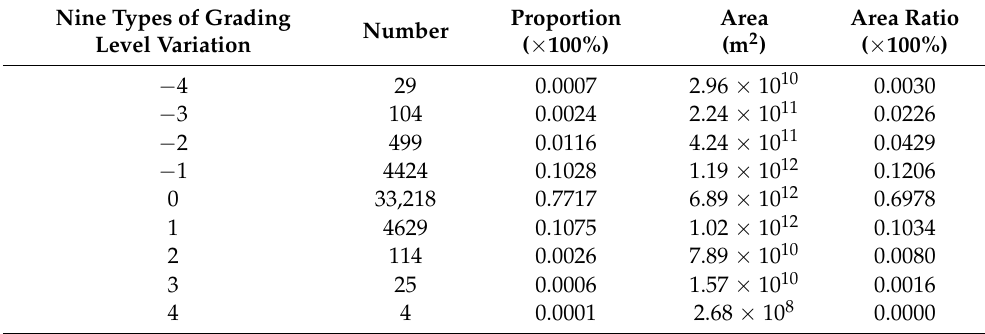
Table 7. Detailed information on the variation in eco–environmental vulnerability from 2000 to